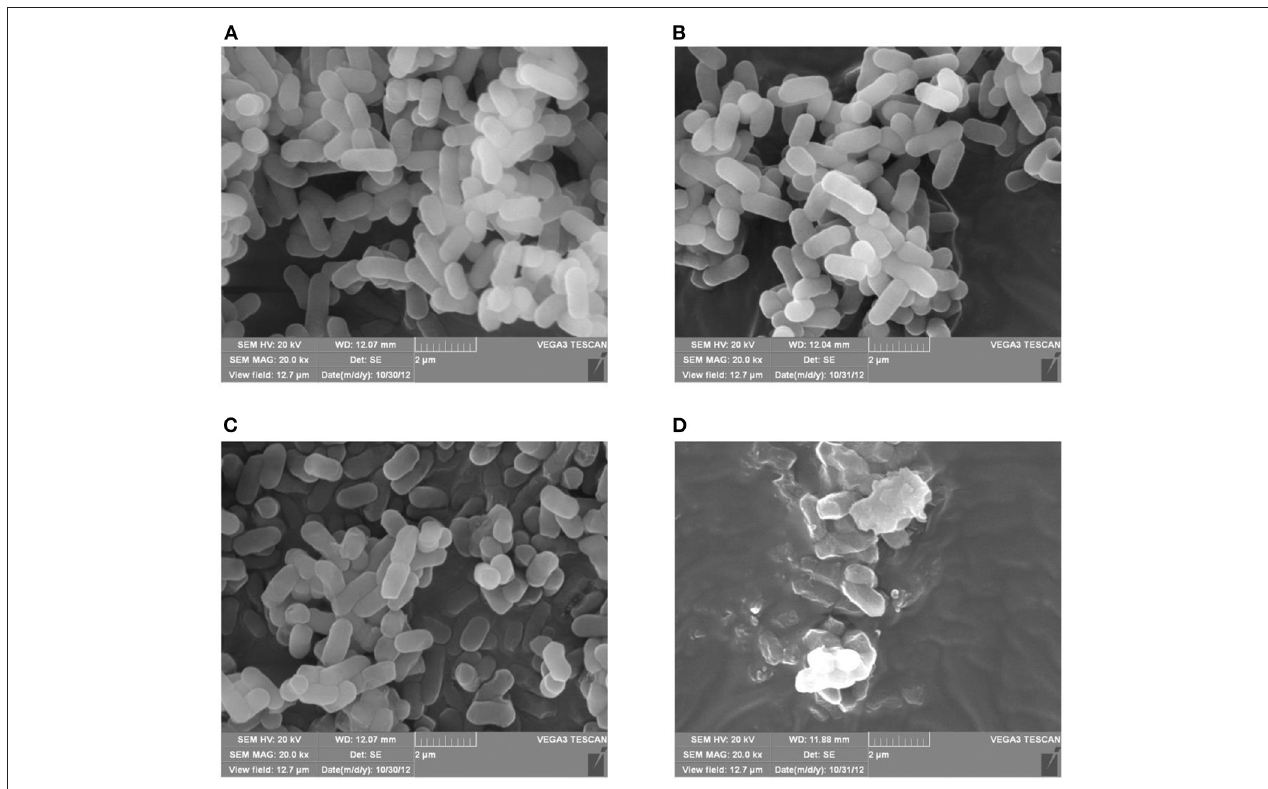
FIGURE 3 | SEM of E. coli K12 and E. coli JW0688 with and without plantaricin BM-1. (A,B) show wild type E. coli K12 and E. coli JW0688 without plantaricin BM-1, respectively; (C,D) show wild type E. coli JW0688 and E. coli K12 with plantaricin BM-1(magnification: 20,000 × ).